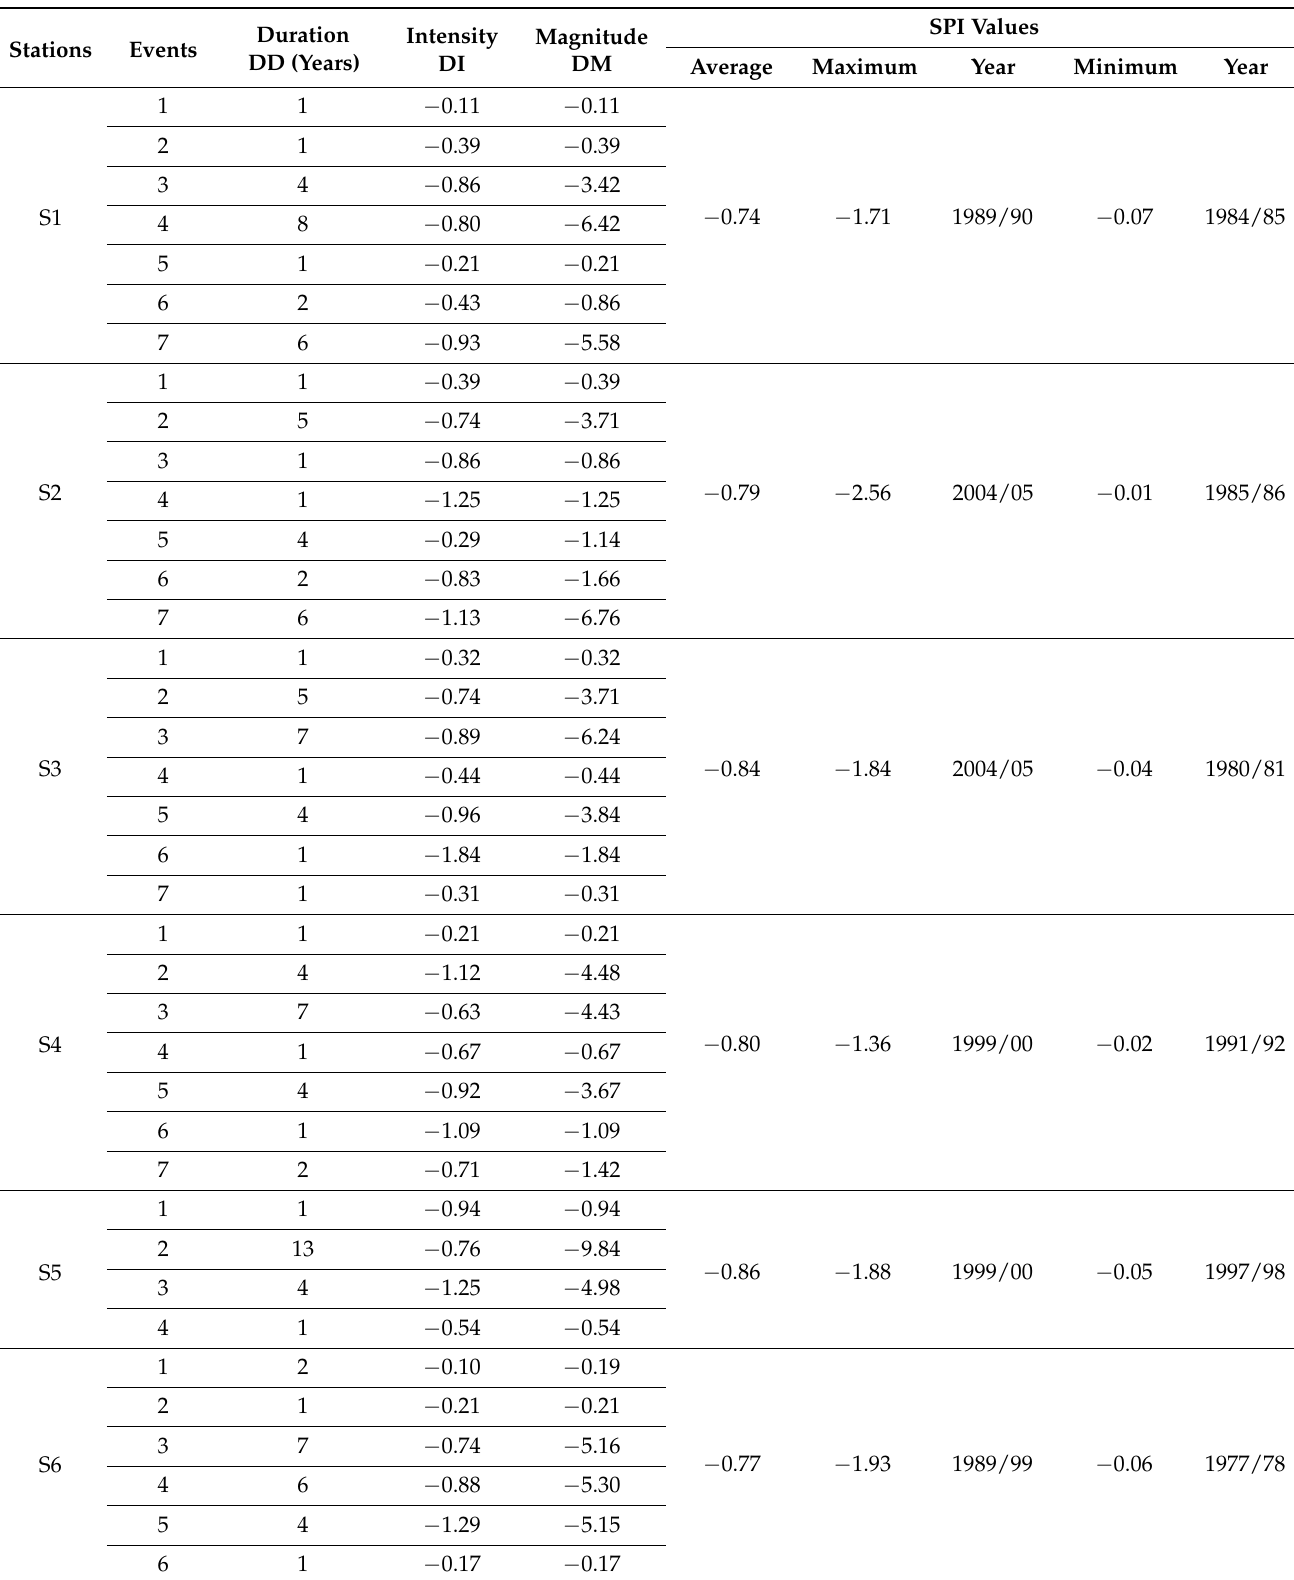
Table 2. Average and maximum annual SPI values during drought years for the meteorological stations